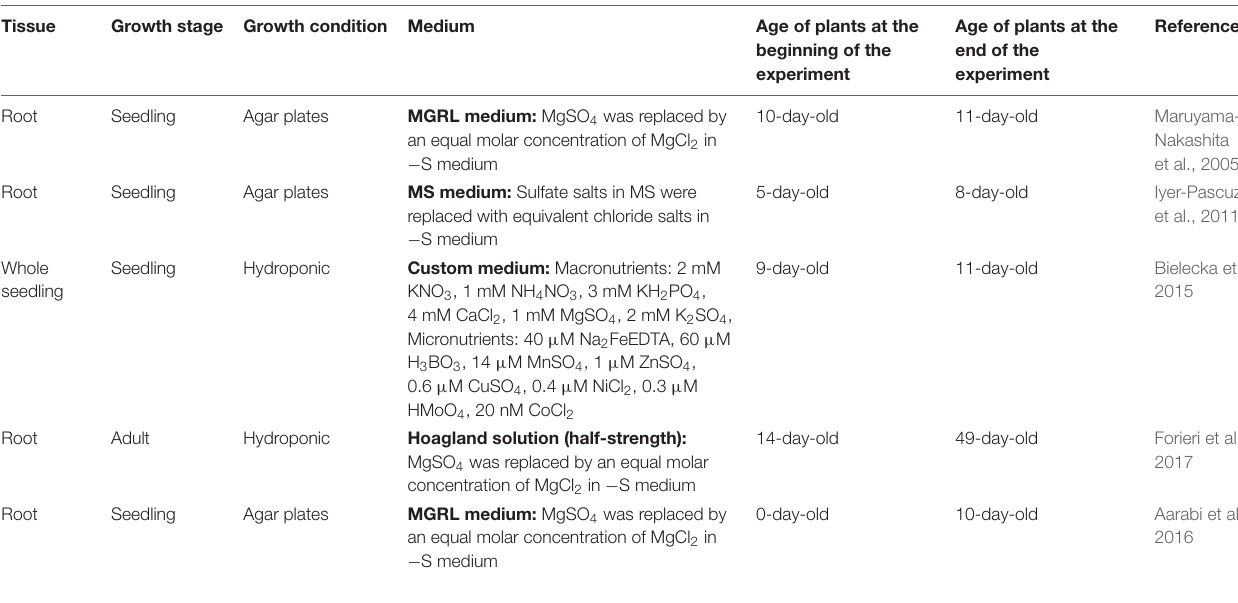
TABLE 1 | Summary of microarray datasets and sample details. Tissue Growth stage Growth condition